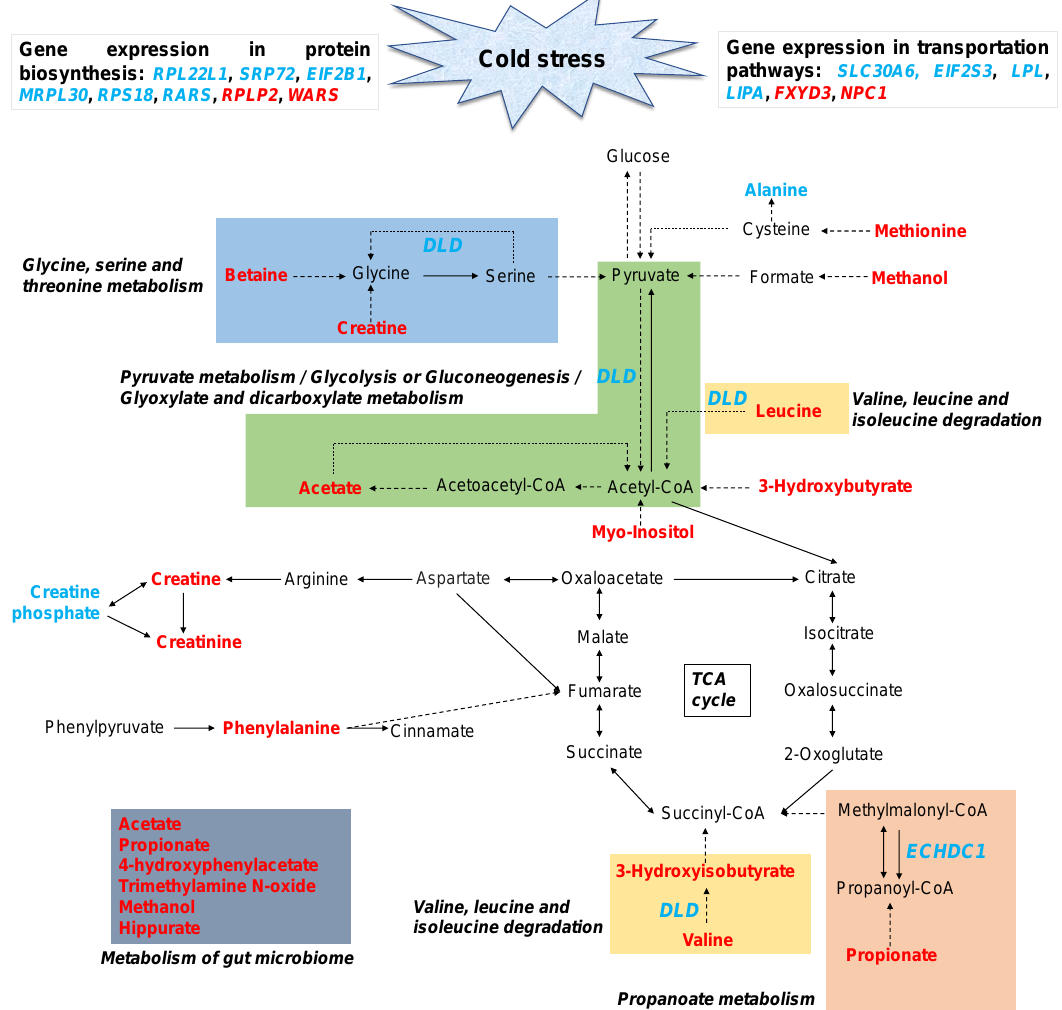
Figure 9. Proposed mechanisms of cold stress response to related functional pathways. Red indicates upregulated metabolites, and blue represents downregulated metabolites, however, blue italics indicates downregulated genes. RPL22L1 : ribosomal protein L22-like 1; SRP72 : signal recognition particle 72 kDa; EIF2B1 : eukaryotic translation initiation factor 2B,